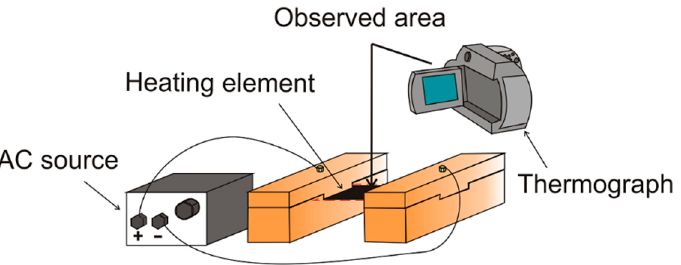
Figure 4. Schematic drawing of experimental setup for measuring the temperature history of heating element.